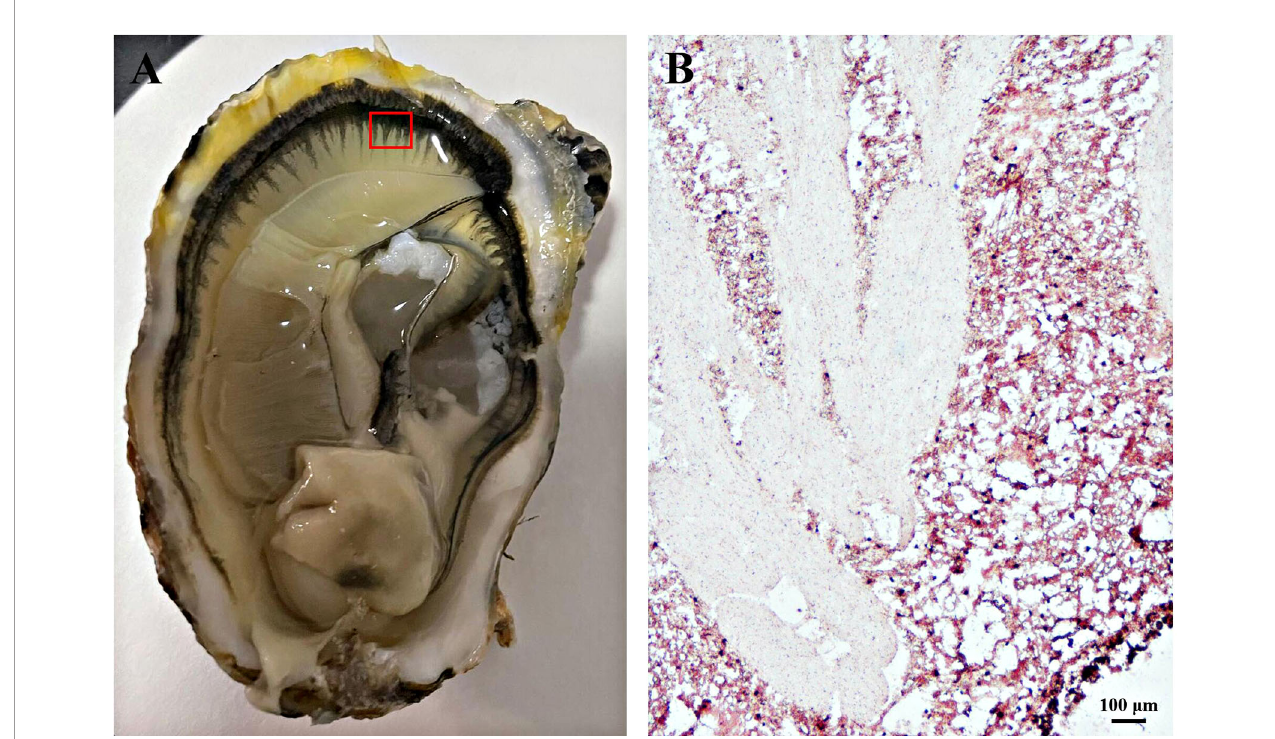
FIGURE 2 | Masson-Fontana staining of melanin in frozen-sectioned mantle tissue. (A) The area of mantle tissue used for frozen section analysis. (B) Masson-Fontana staining of melanin in mantle tissue and counterstaining with neutral red stain. Brown or black particles indicate positive results. Bar, 100 m m.